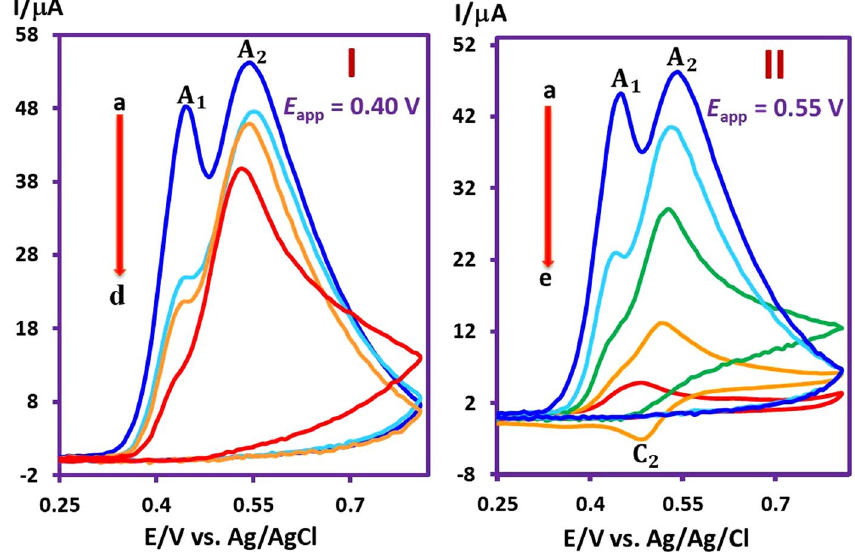
Figure 2. Cyclic voltammograms of MAP (0.25 mmol) in the presence of BS (0.5 mmol) during CPC at 0.40 (part I) and 0.55 (part II) V vs . Ag/AgCl. Part I: the consumed charge is (a) 0, (b) 16, (c) 32 and (d) 47 C. Part II: the consumed charge is (a) 0, (b) 40, (c) 70, (d) 90 and (e) 110 C. Other conditions are as same as Fig. 1.